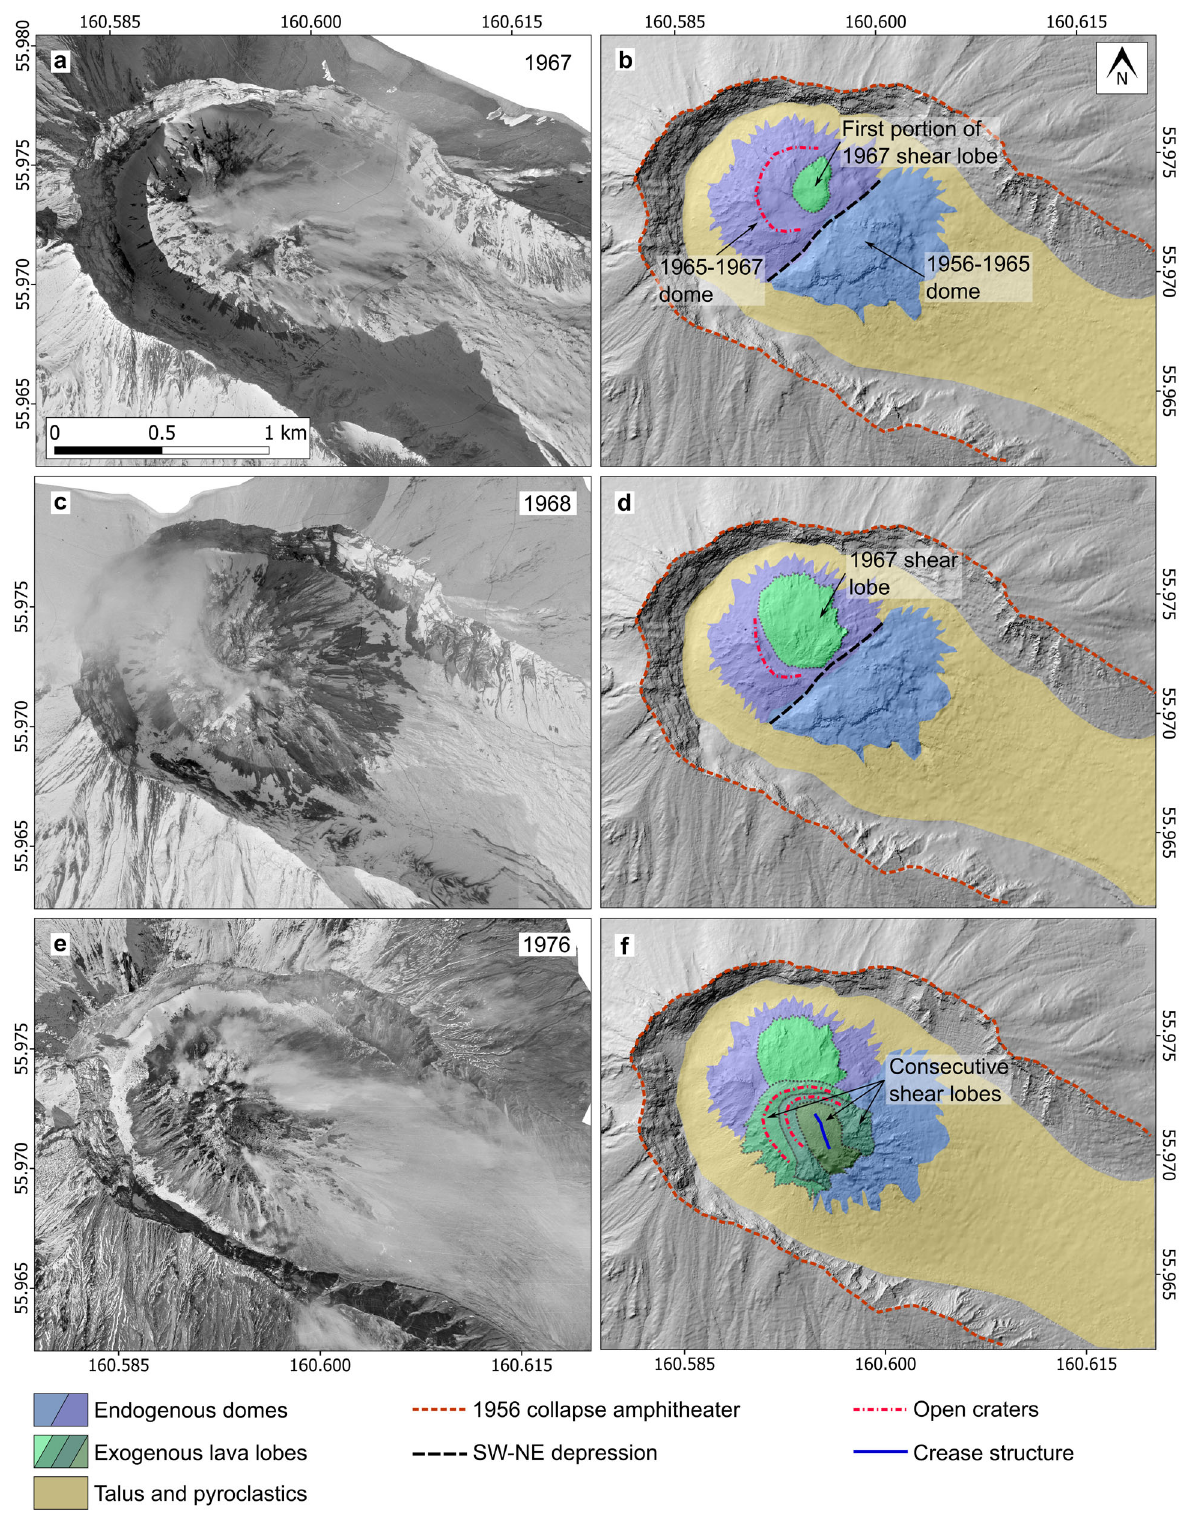
Fig. 3 Exogenous (extrusive) dome growth in 1967 – 1976. Aerial orthophotos a , c , e and derived hillshade maps b , d , f show that viscous shear lobes extrude from multiple open craters and pile up at different sectors of the previously formed endogenous